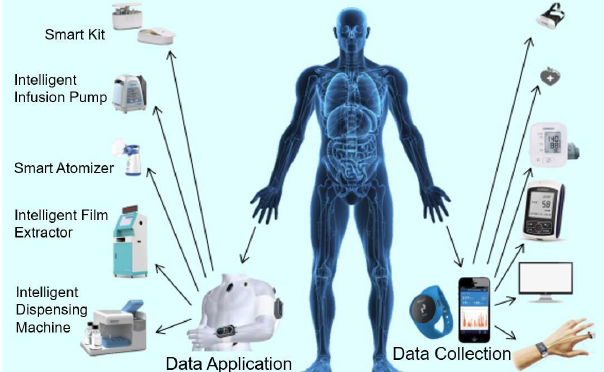
Figure 1. Healthcare devices.